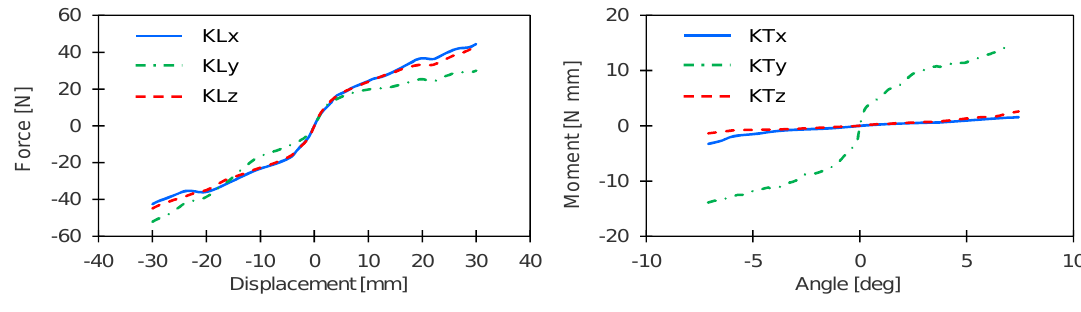
Figure 6. Stiffness